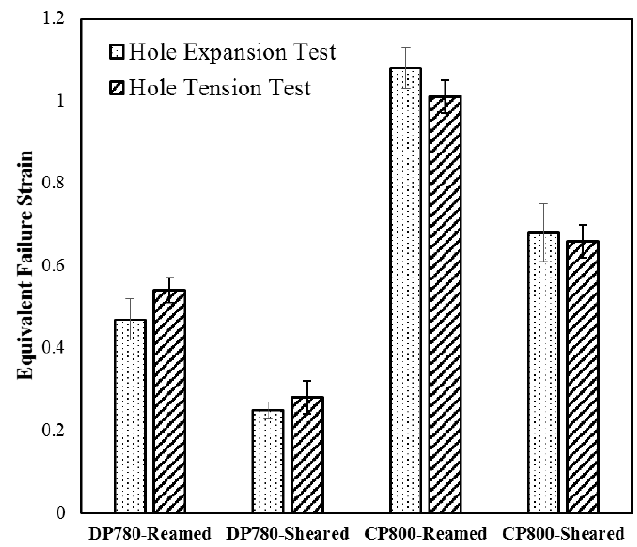
Figure 9. Equivalent failure strain for the DP780 and CP800 obtained during the current hole tension and hole expansion tests for the reamed versus sheared edges.